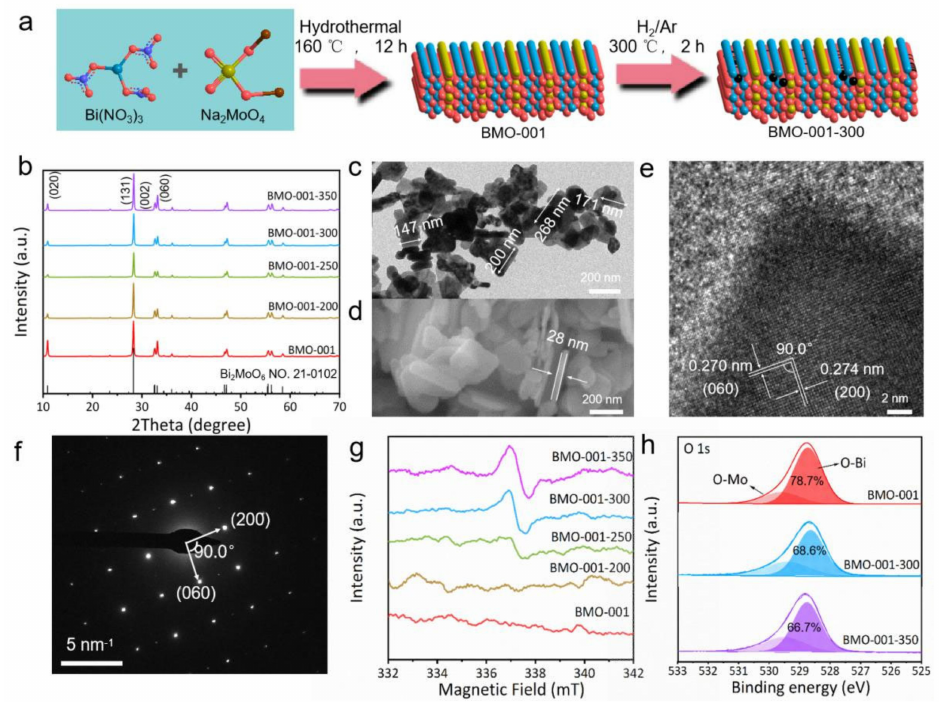
Figure 1. ( a ) Schematic illustration of BMO-001-300 preparation with calcination treatment; ( b ) XRD patterns of as-prepared Bi 2 MoO 6 samples; TEM ( c ), SEM ( d ), HRTEM ( e ) and SAED ( f ) images of BMO-001-300; ( g ) EPR spectra of oxygen vacancies on as-prepared Bi 2 MoO 6 samples; ( h ) high- resolution XPS spectra of O 1s for BMO-001, BMO-001-300,